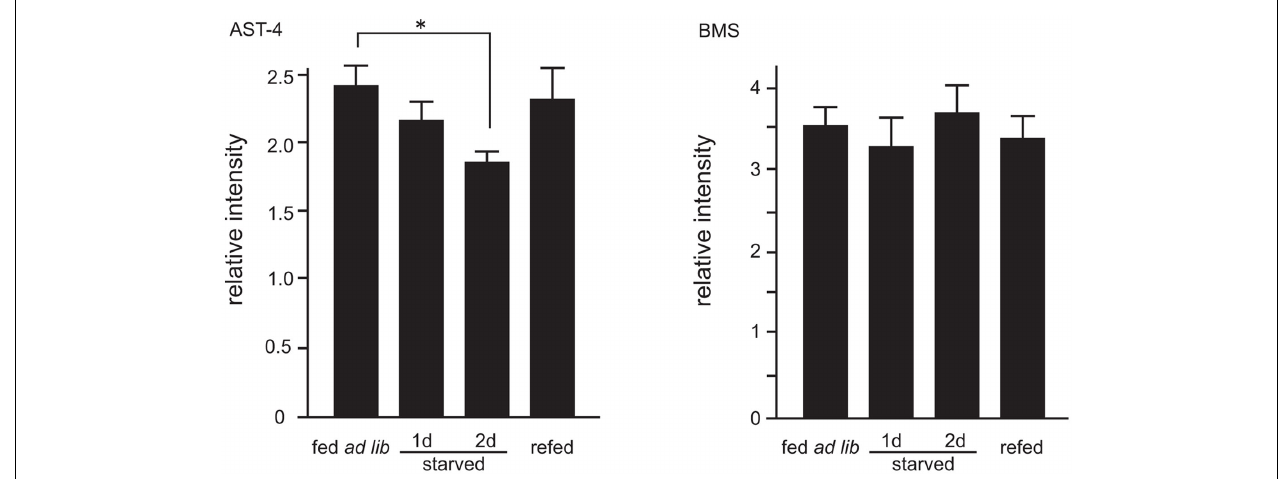
as those for sNPFs analyses. N = 5, Mean ± SE. Data was statistically analyzed by one-way ANOVA. Significant differences were determined by the post hoc Dunnett’s test, * P <